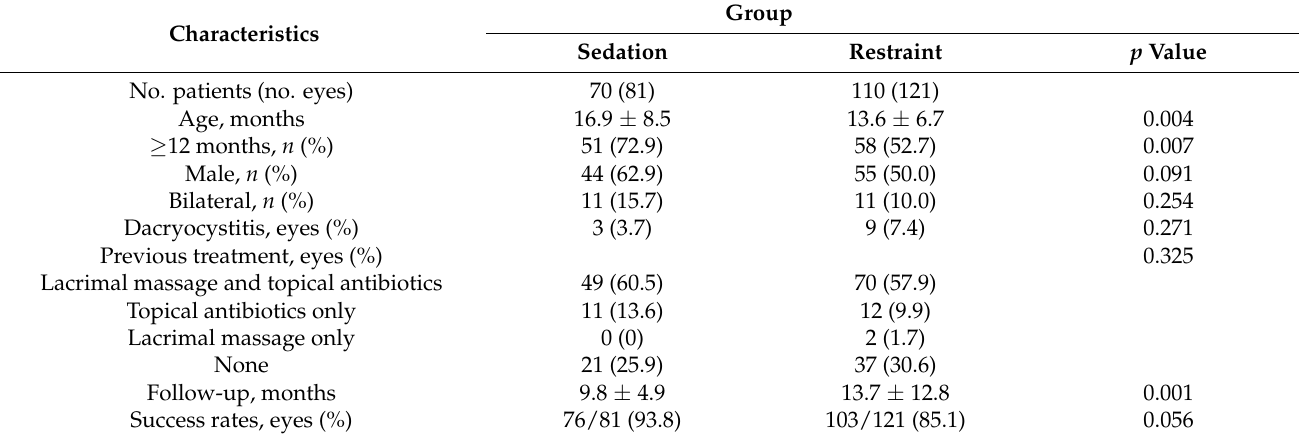
Table 1. Comparison of patients’ characteristics and outcomes for office probings under sedation and restraint.